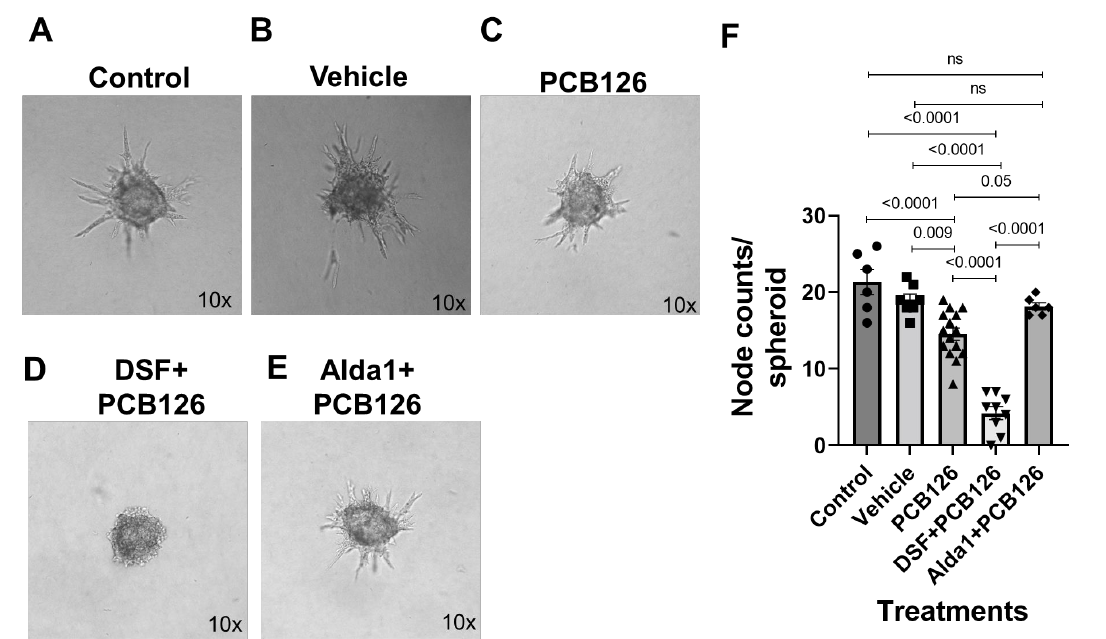
Figure 6. ( A – E ) Representative micrographs of sprout formation by the control, vehicle, 4.4 µM PCB126, 2.5 µM DSF + 4.4 µM PCB126, and 10 µM Alda1 + 4.4 µM PCB126-treated spheroids on a collagen matrix for 48 h, respectively. Magnification: 10×. ( F ) Quantitative data of the node counts/spheroids with different treatments stated in ( A – E ). n = 6–15 for each group. Each bar represents the mean ± SEM. DSF, disulfiram; PCB, polychlorinated biphenyl; ns, not significant. The aortic ring assay data showed that 4.4 µM PCB 126-treated aortic rings signifi- cantly decreased the sprouting area compared with the vehicle ( p = 0.002) (Figure 7A,B,D). A 10 µM Alda 1 pretreatment for 2 h, followed by the treatment with PCB 126 for 72 h, rescued the PCB 126-mediated decrease in the sprout counts ( p = 0.003 vs. PCB 126) (Figure 7B – D).